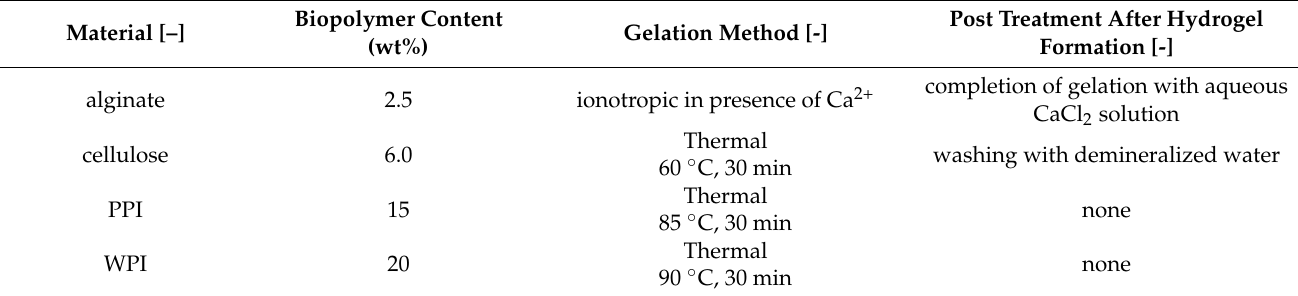
Table 1. Biopolymer content and gelation conditions for production of hydrogels from different biopolymers. Post Treatment After Hydrogel Biopolymer Content Gelation Method [-] Material [–] Formation [-] (wt%) completion of gelation with aqueous alginate 2.5 ionotropic in presence of Ca 2+ CaCl 2 solution washing with demineralized cellulose 60 ◦ C, 30 min